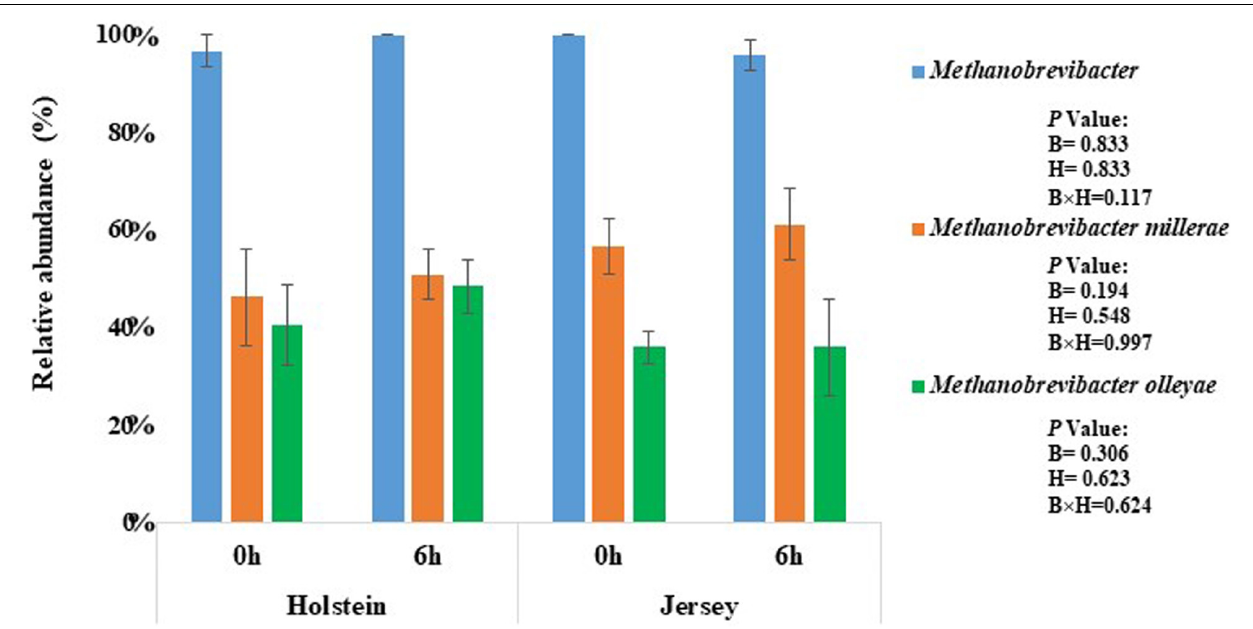
FIGURE 1 | Methanogens identified in the rumen of the Holstein and the Jersey Steers. Blue bars, Methanobrevibacter ; orange bars. M. millerae ; and green bars, M. olleyae .